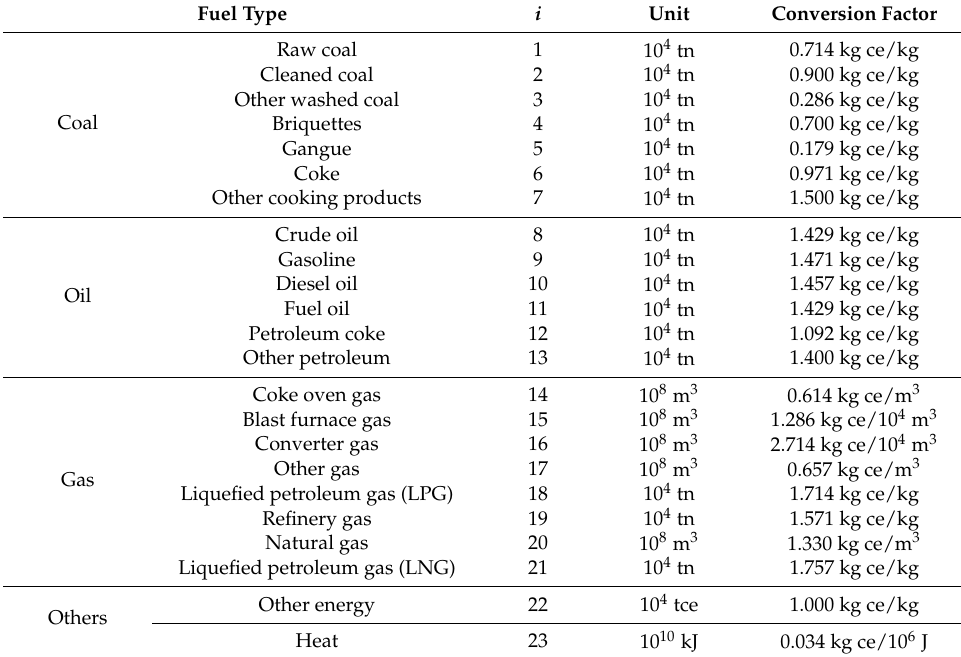
Table 1. Conversion factors for different fuel types from physical units to coal equivalent.